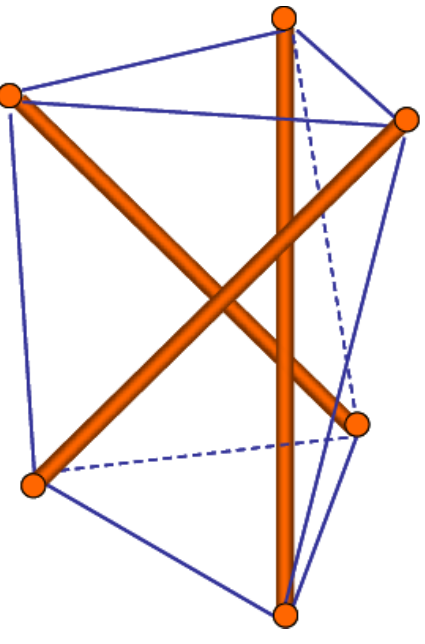
Figure 4: A minimal tensegrity system is generated by three struts (orange) that are interconnected by cords (blue). There is a continuum of communication between the participating elements and the system is held together by tensegritic forces. A single cut in one of the communicating strings would result in the collapse of the system that, otherwise, is able to support a substantial weight (author’s drawing modified from http://www.tensegriteit.nl/e-